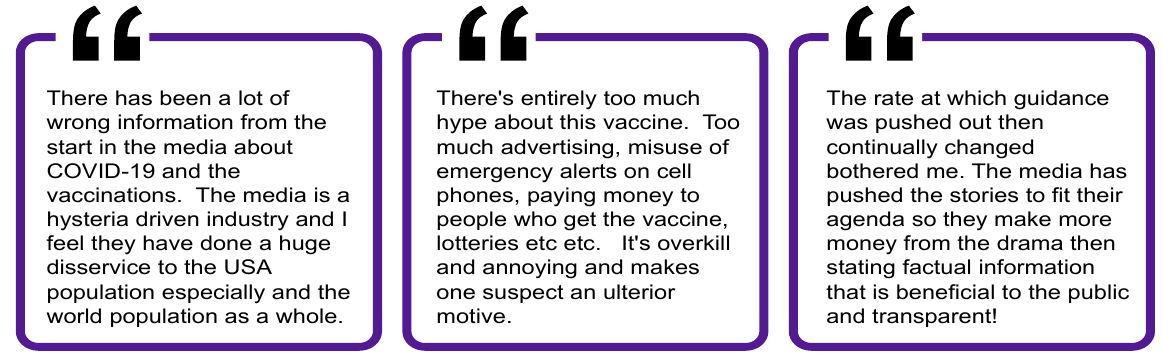
Figure 6. Participant perspectives regarding mistrust in media.